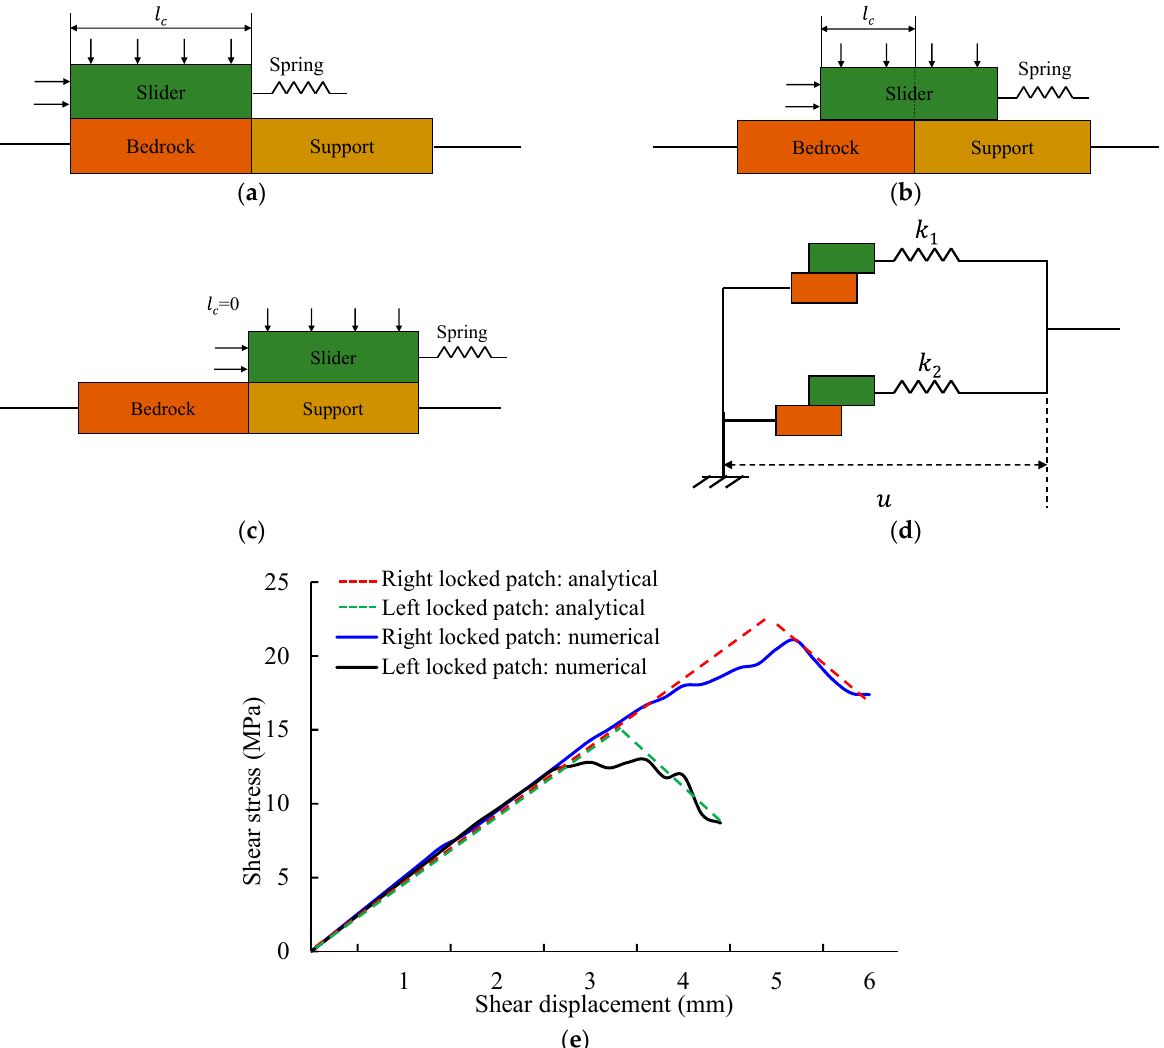
Figure 12. Schematic of the contact states: ( a ) stationary state, ( b ) sliding state, ( c ) separated state, ( d ) simplified model with two locked patches, and ( e ) fitting curves of the model with two identical locked patches.